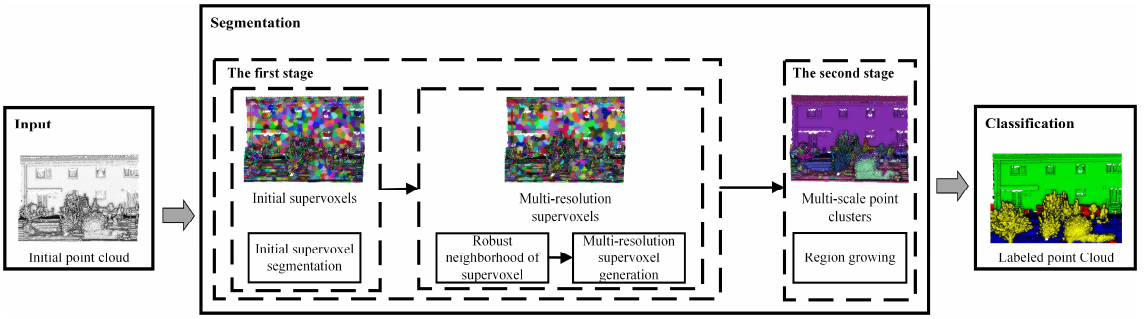
Figure 1 . Workflow of our